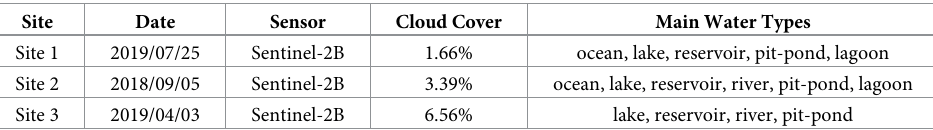
Table 1. Specific information of selected Sentinel-2